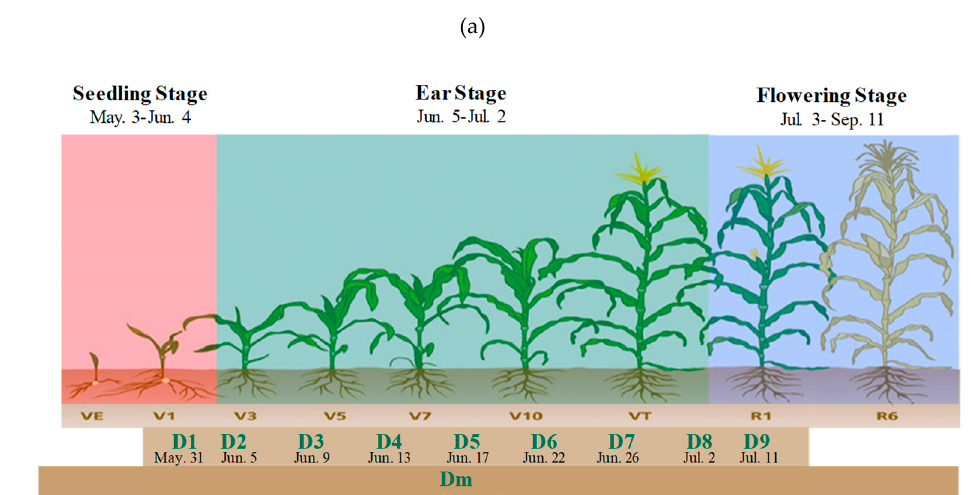
Figure 3. Comparison of soil NO 3 − ‐ N predicted with ISE raw , ISE OS , and ISE.